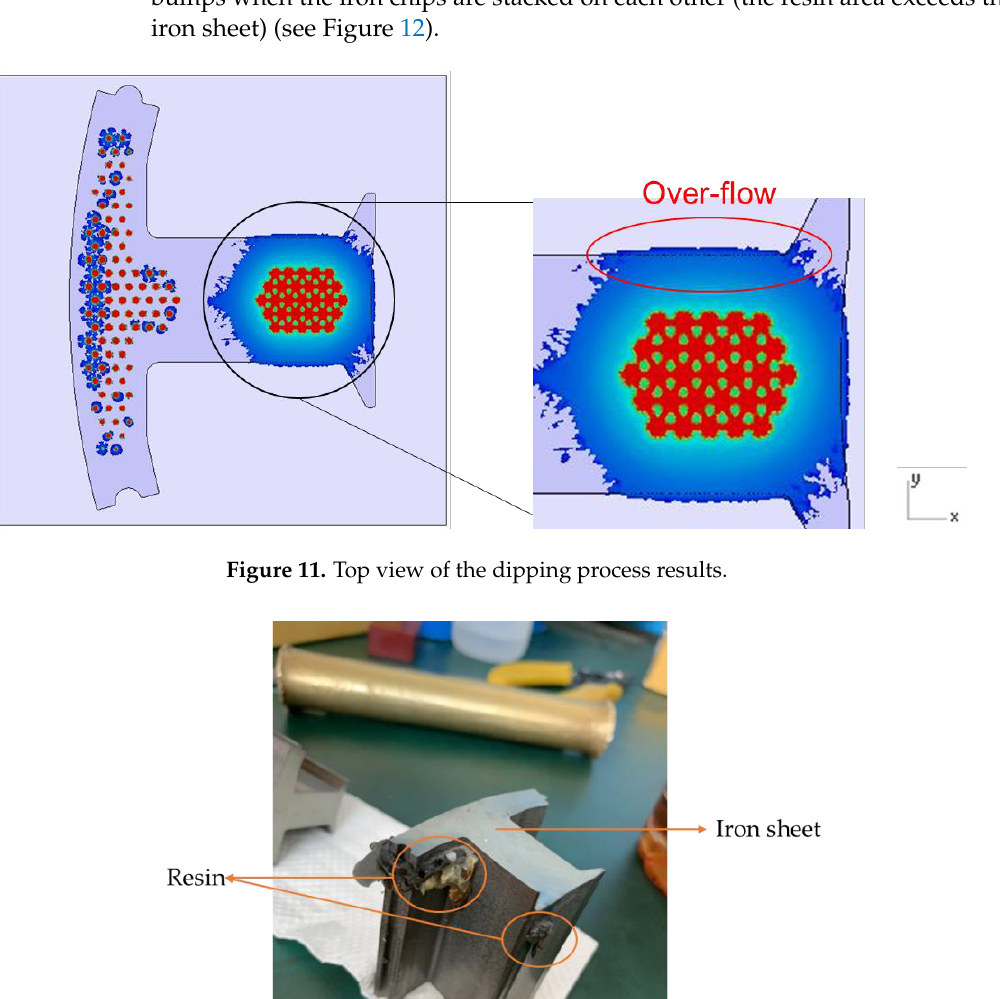
284 Figure 13. Position of air traps.